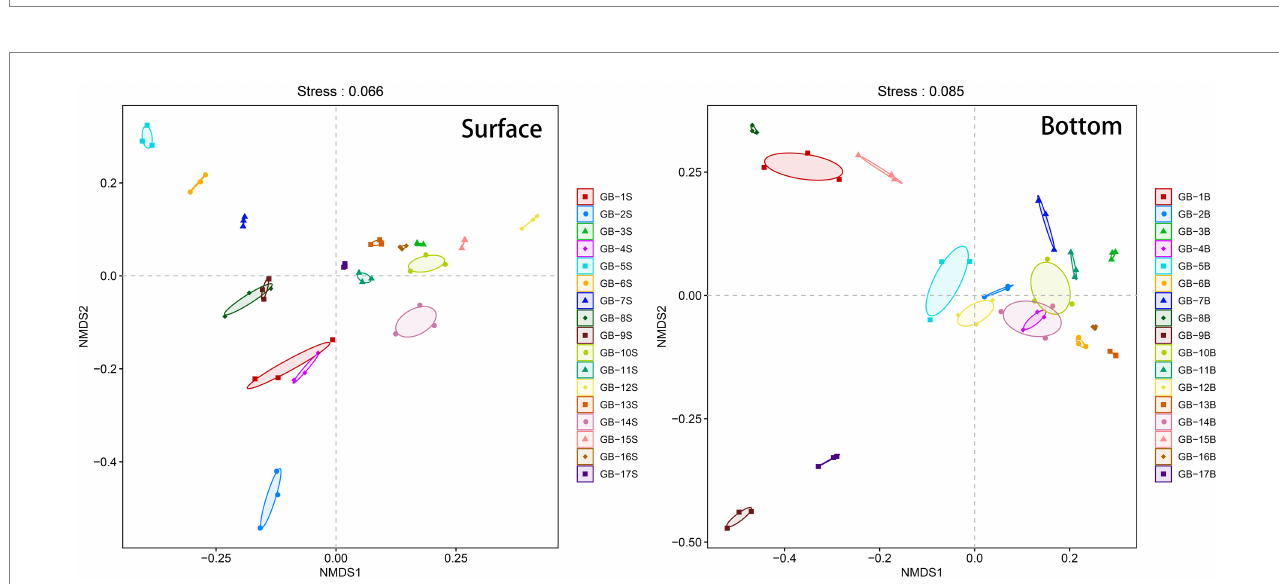
FIGURE 4 Beta-diversity (Non-metric multidimensional scaling, NMDS) of eukaryotic plankton in surface and bottom layers. The three points corresponding to each site in the figure are three PCR replicates. The Stress parameter is below 0.1, indicating that the sorting results are